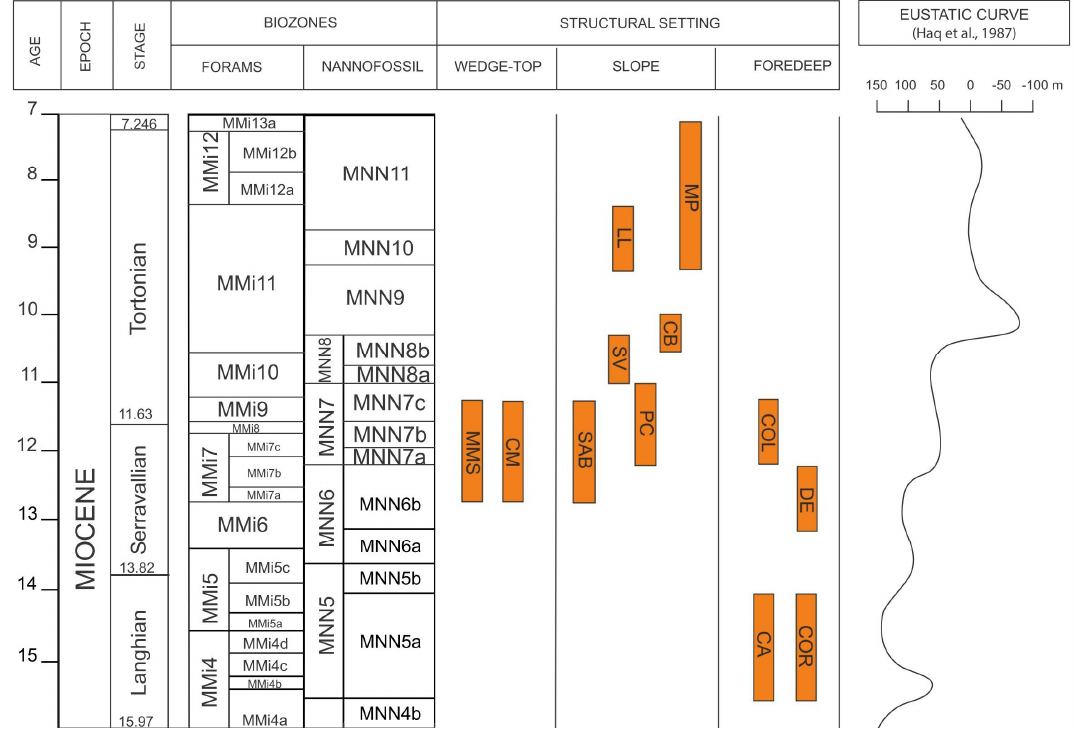
Figure 7. Biostratigraphic scheme, based on nannofossil and foraminifera assemblages, indicating the Miocene biozones and the stratigraphic distribution of the examined outcrops. For the full name of the outcrops refer to Figure 1. The third‐order eustatic curve is reported to show a possible correlation between the development of seepage systems and low stands.